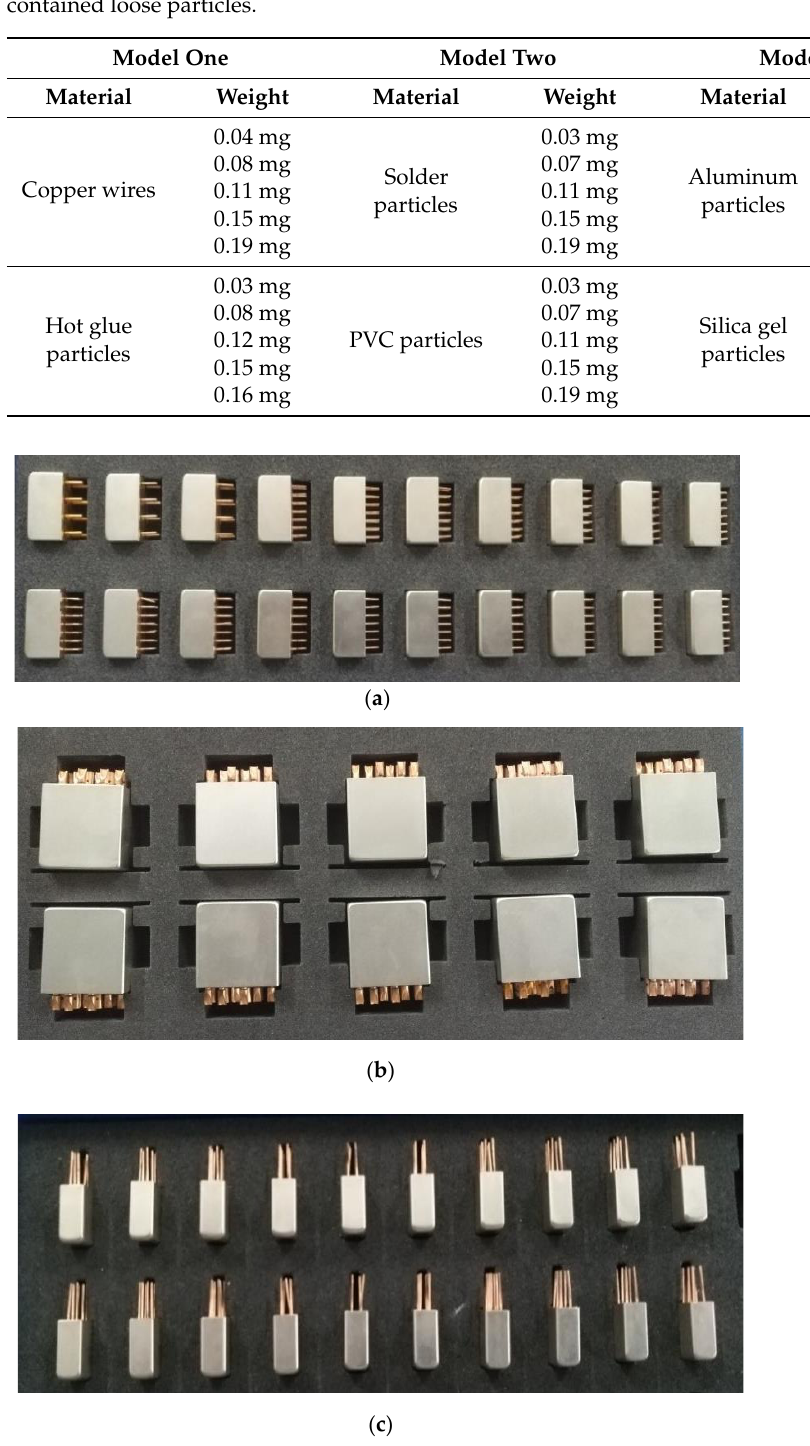
Figure 3. Sealed relay samples. ( a ) Sealed relay samples of model one; ( b ) sealed relay samples of model two; ( c ) sealed relay samples of model three. Table 1. Model of the sealed relay samples, material information, and weight information about the contained loose particles.